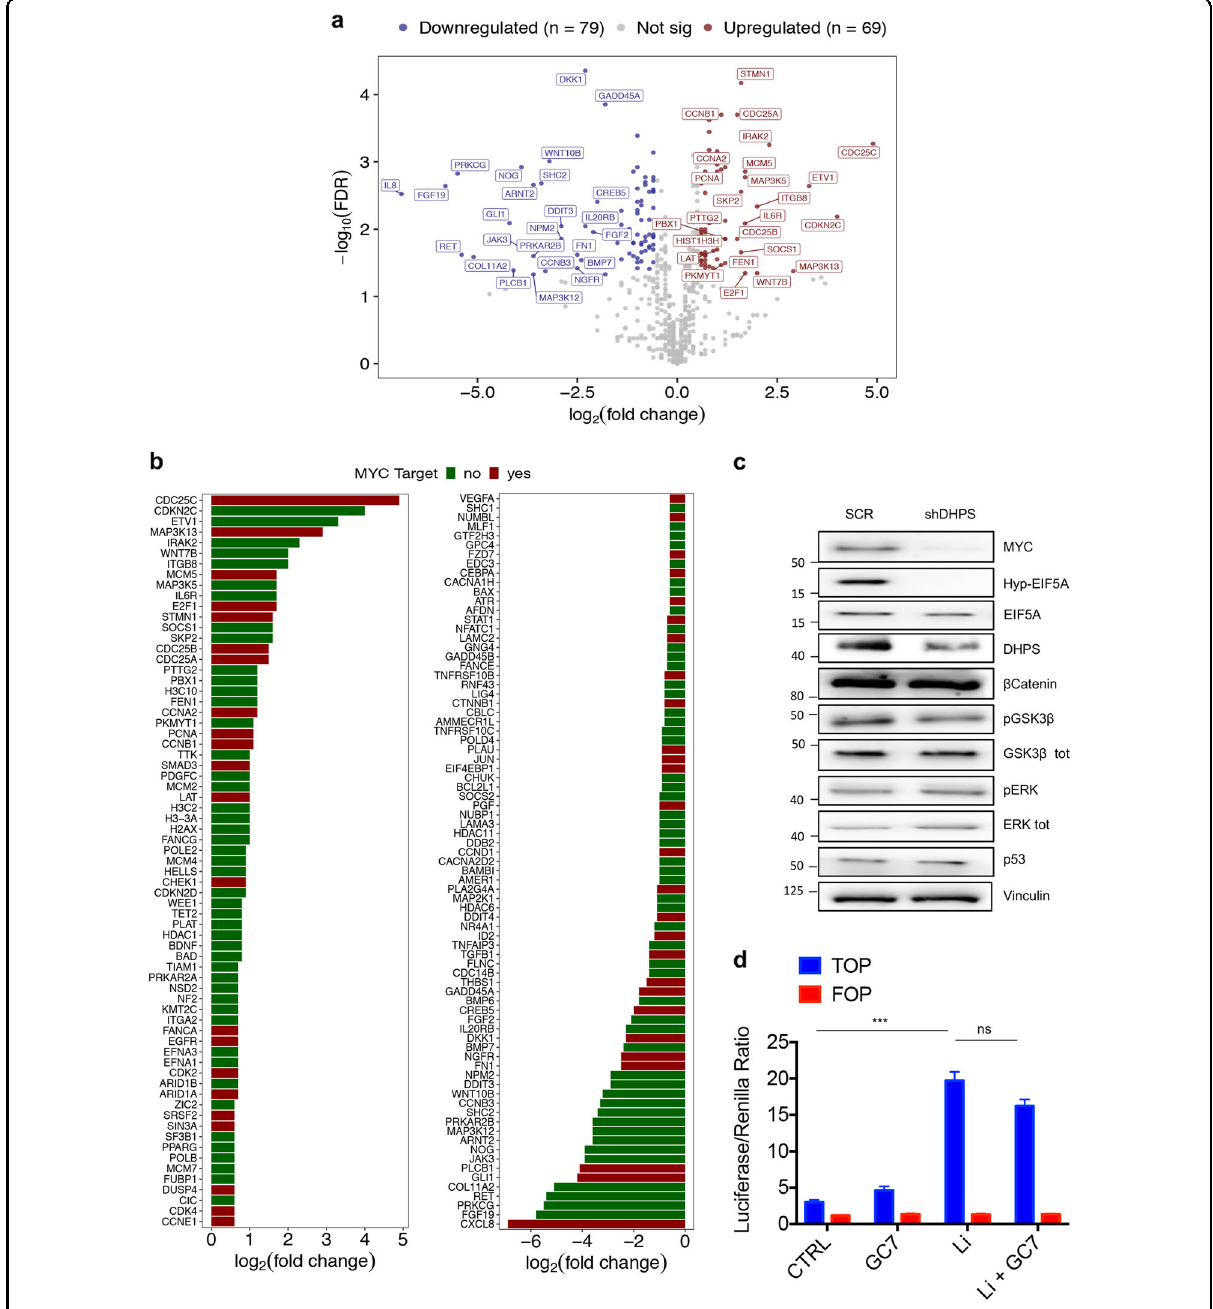
Fig. 2 Gene expression pro fi ling reveals that DHPS inhibition downregulates MYC. a Volcano plot displaying the 148 differentially expressed genes in shDHPS vs. SCR. Axes show logarithmic transformation of fold change (x-axis) and p -values (FDR). Genes signi fi cantly upregulated ( n = 79) and downregulated ( n = 69) with an FDR < 0.05 and a log2(fold change) < − 0.58 or >0.58 are represented in red and in dark blue, respectively. Labeled points indicate the fi rst 25 upregulated and fi rst 25 downregulated genes. b Barplot showing the log 2 (fold change, shDHPS vs. SCR) of the signi fi cantly upregulated (left panel) or downregulated (right panel) genes. Red bars indicate MYC target genes. c Western blotting of HCT116 infected with lentiviruses expressing shDHPS or SCR for 72 h, then selected with puromycin for 72 h. Staining for MYC, Hyp-EIF5A, EIF5A, DHPS, β -Catenin, pGSK3 β , GSK3 β , pERK, ERK, and p53. Vinculin, loading control. d Luciferase assay ( n = 3) in HCT116 cells transfected for 24 h with TCF/LEF responsive reporter TOP or its negative control FOP. The day after transfection, cells were serum starved for 8 h and treated with 50 mM lithium chloride and 100 µM GC7 for other 24 h. For Statistical analysis: ns not signi fi cant, * p < 0.05, ** p < 0.01, *** p < 0.001, by Student ’ s t -test. Data represent the mean ± SD of experiments performed in triplicates and repeated at least three